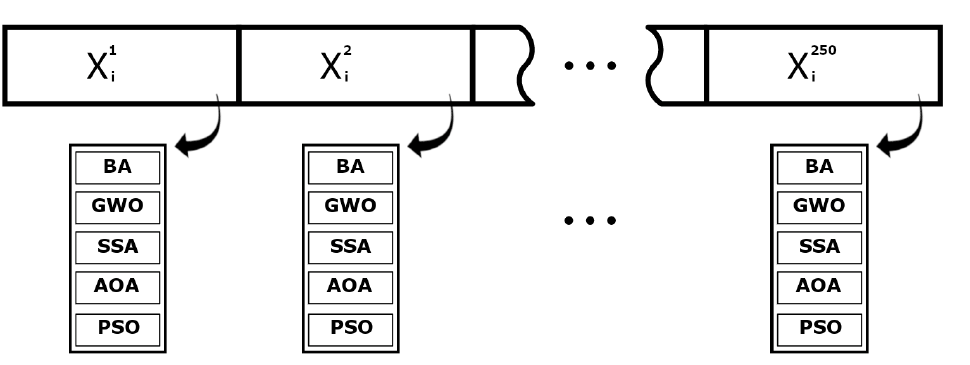
Figure 3. Database generation